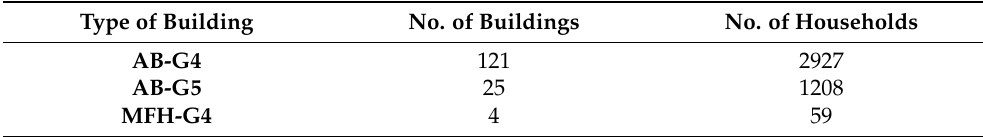
Table 1. Classification of buildings and dwellings of L’Illa Perduda—Tabula project. Type of